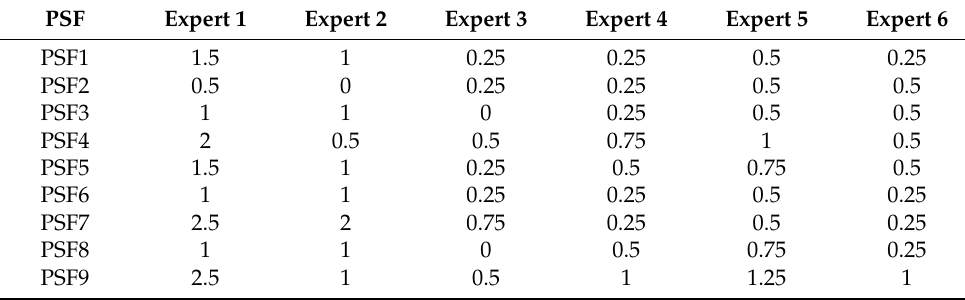
Table 7. The collected likelihood data of each PSF concerning ST